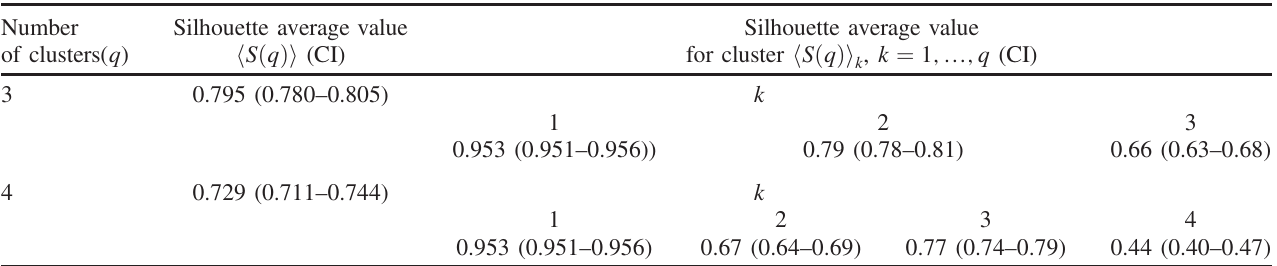
TABLE II. Silhouette values for clusters depicted in Fig. 3. The confidence intervals are reported according to a significance level (CI) of 95%.